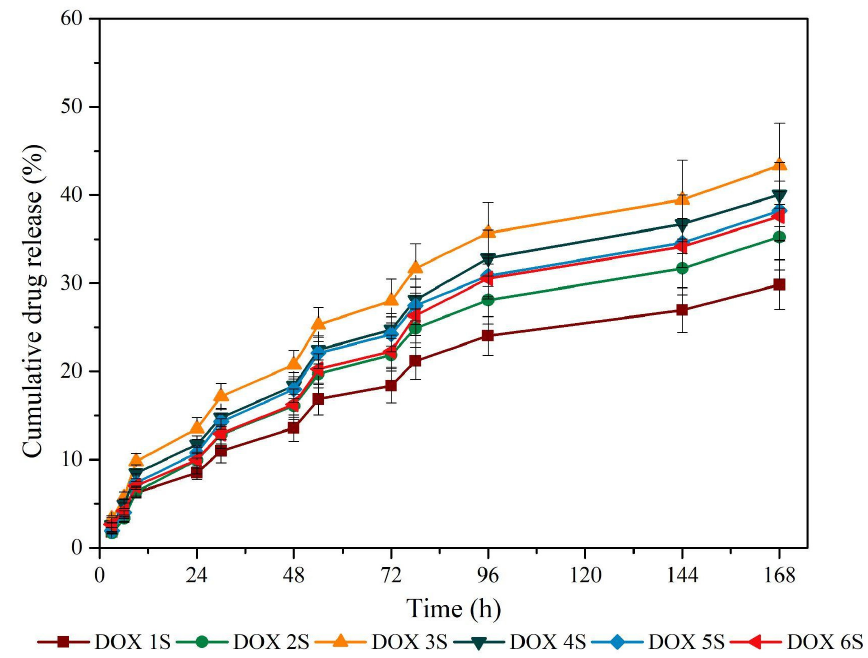
Figure 6. Release profile of all PLGA + DOX samples submitted to sonication (S).